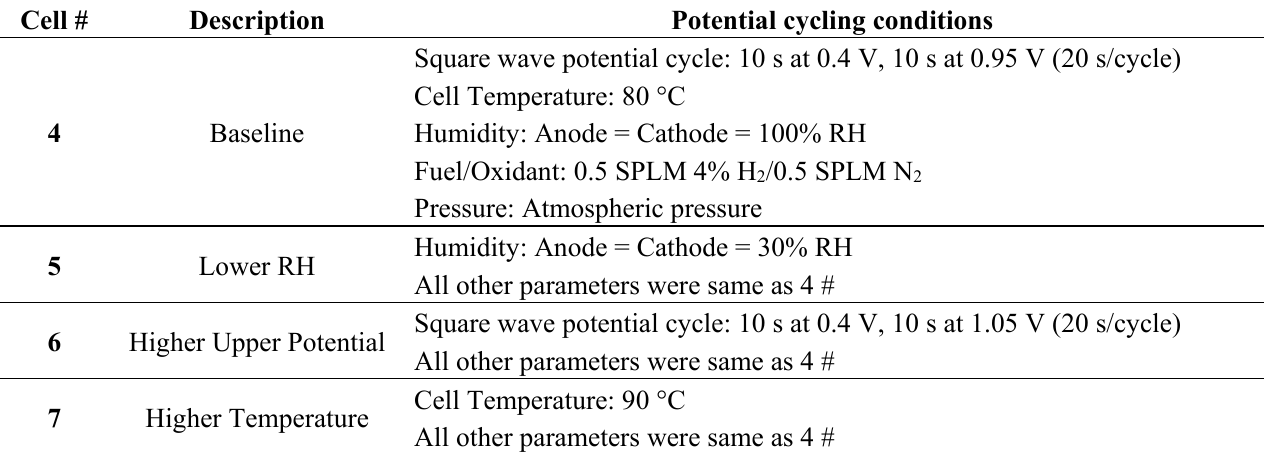
Table 3. Operating conditions used for testing the electrochemical stability of the 4.9 nm Pt 3 Co